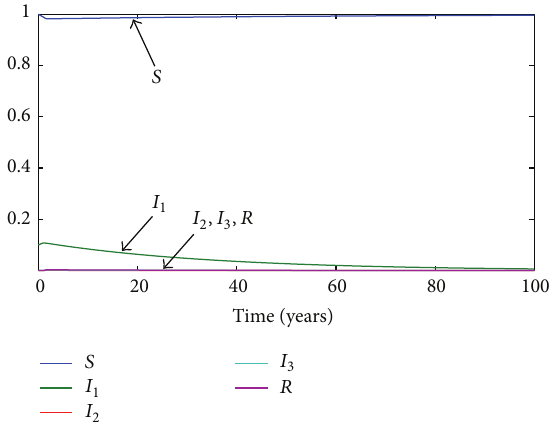
Figure 8: Dynamics of the subpopulations of the 𝑆𝐼(3)𝑅 discrete delayed model for 𝑅 0 = 0.92